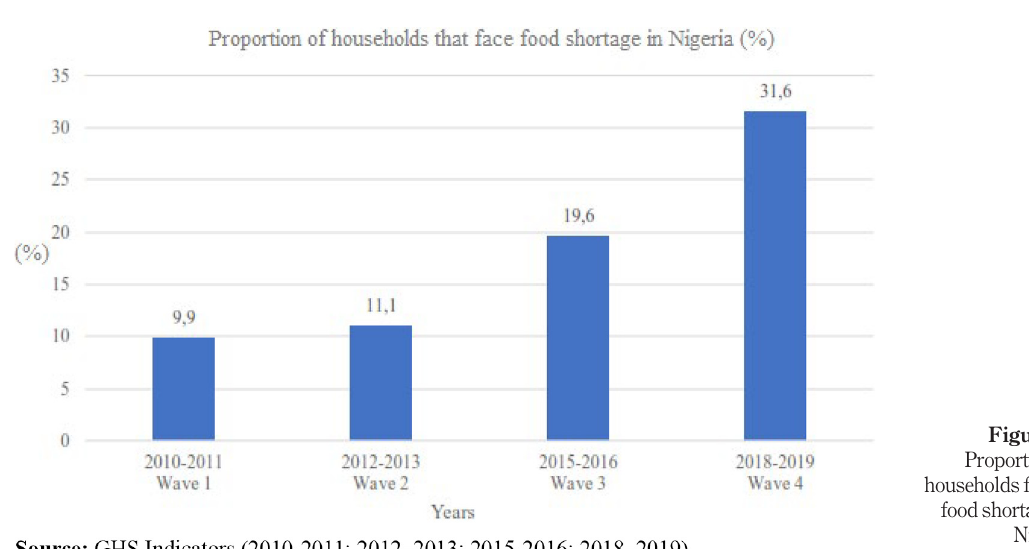
Figure 1. Prevalence of